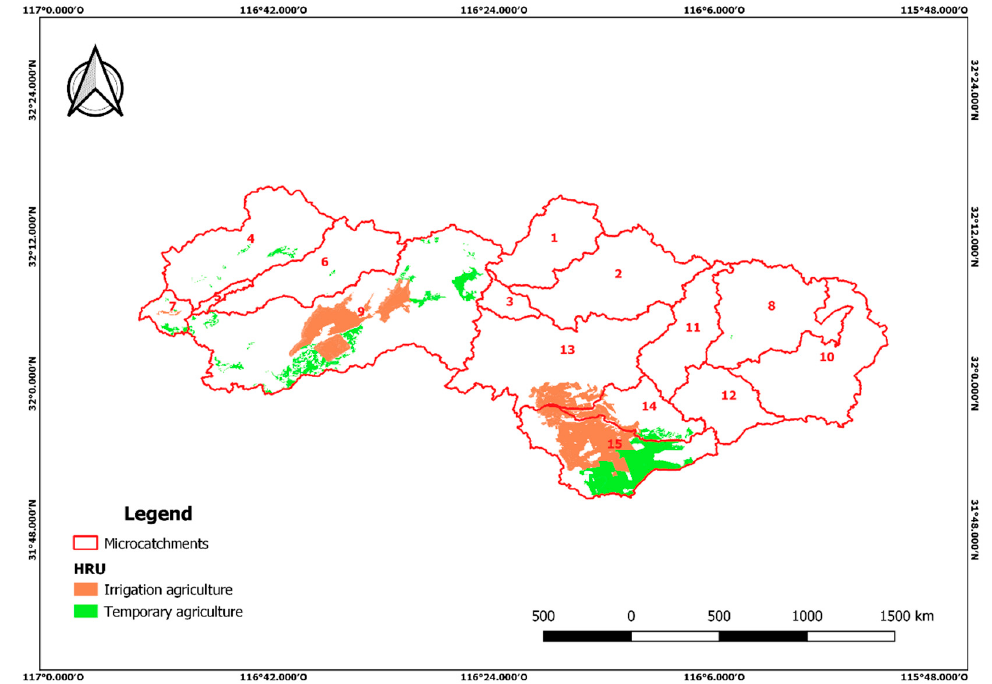
Figure 7. Map of Hydrological Response Units of interest in the Study Area.